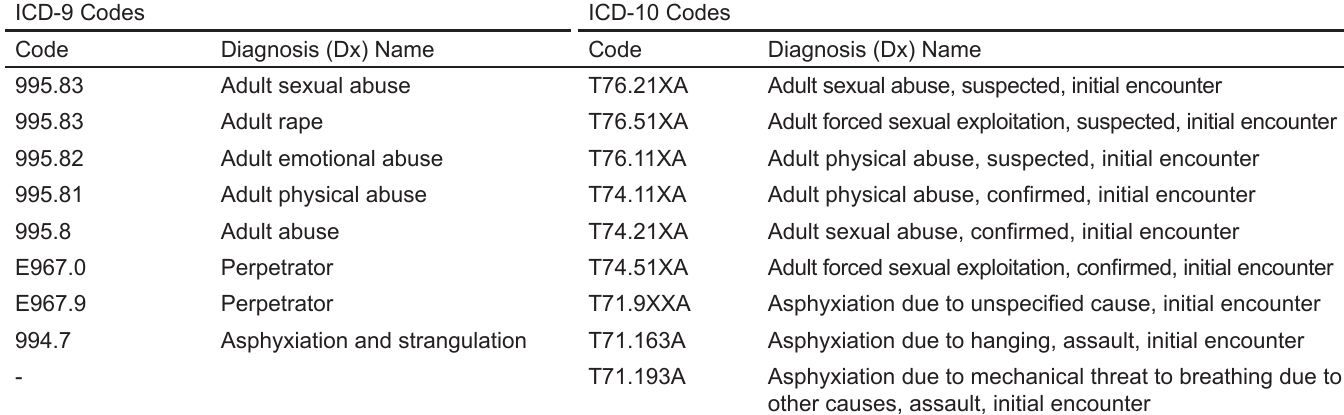
Table 1. ICD-9 and ICD-10* used to identify cases of intimate partner violence in an emergency department